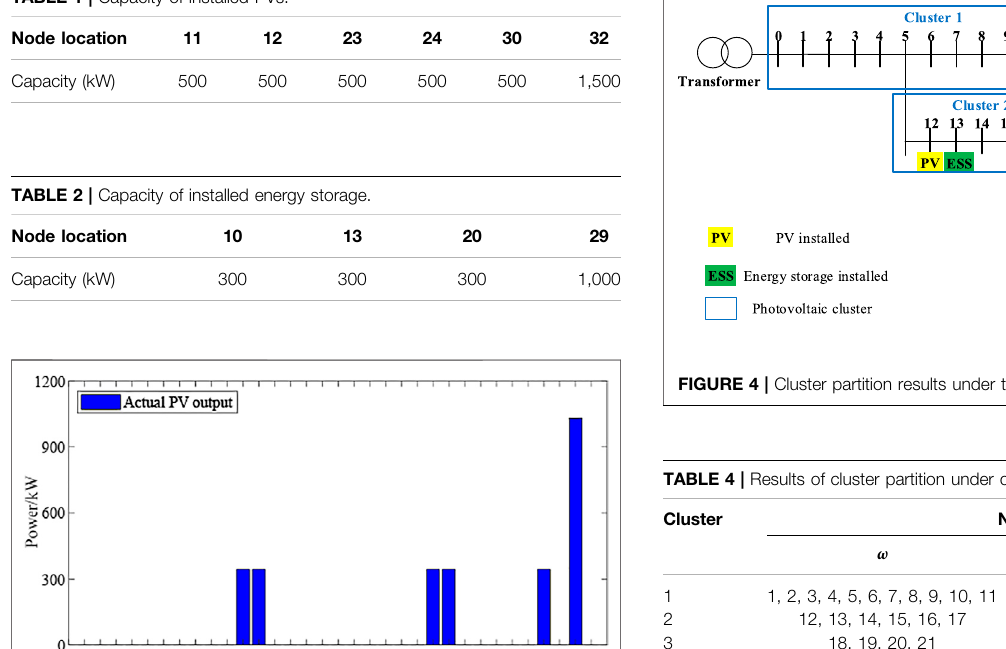
TABLE 1 | Capacity of installed PVs.